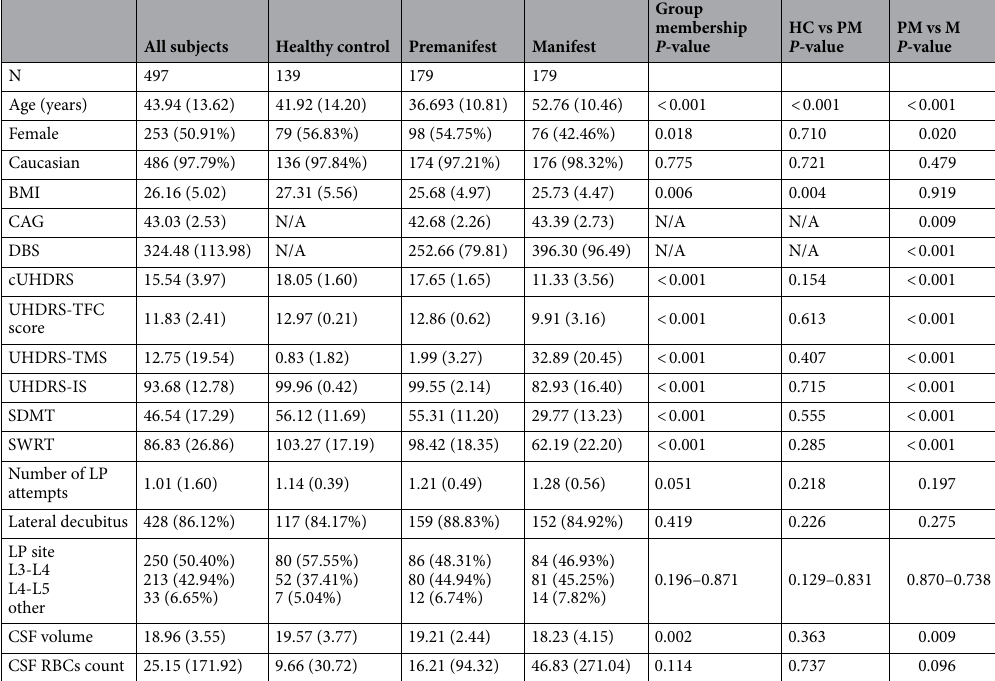
Table 1. Baseline demographics and disease characteristics and CSF sample methodology at first LP visit. Continuous variables are reported as mean (standard deviations). Categorical variables are reported as absolute and relative frequencies. BMI body mass index , CAG HTT CAG size , DBS Disease Burden Score , cUHDRS composite Unified Huntington’s Disease Rating Scale , TMS UHDRS Total Motor Score , TFC UHDRS Total Functional Capacity , IS UHDRS Independence Scale , SWR Stroop Word Reading test , SDMT Symbol Digits Modality Test , RBCs Red Blood